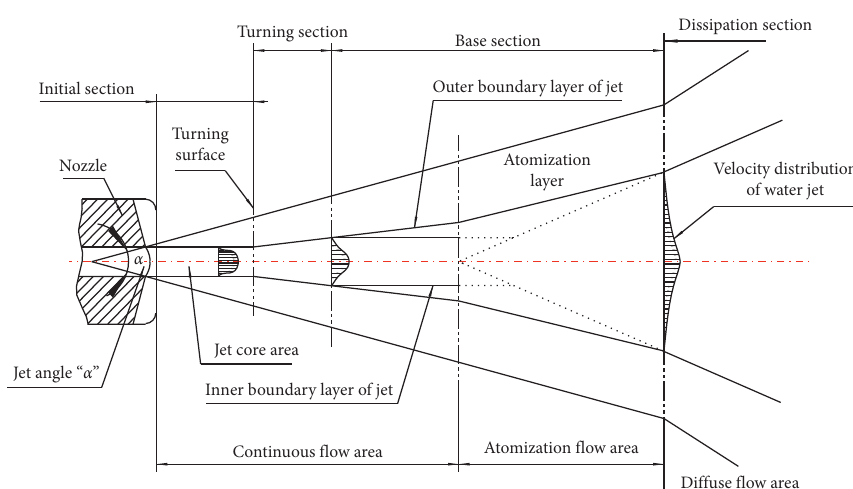
Figure 2: The jet distribution structure diagram of the